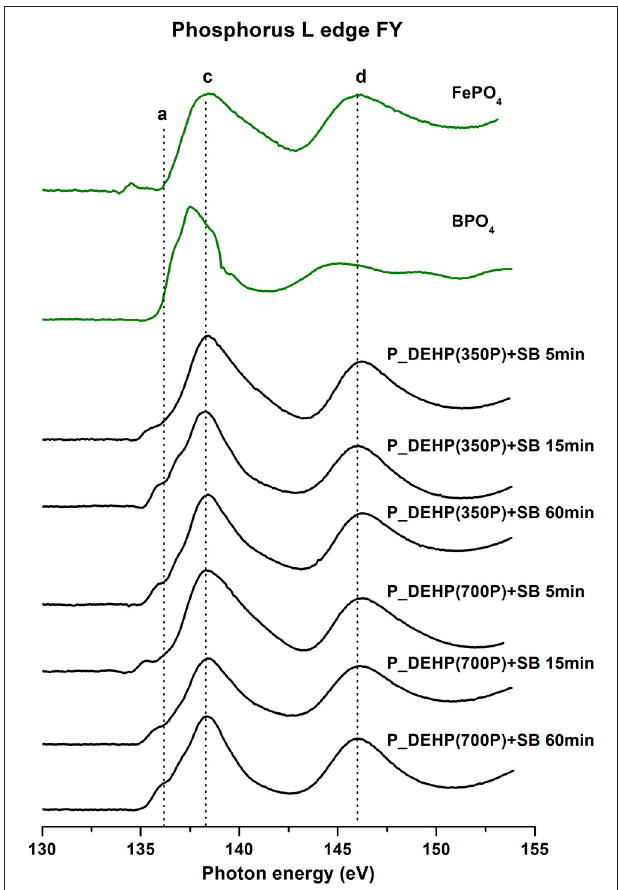
FIGURE 8 | Phosphorus L-edge FY spectra of tribofilms (black lines) derived at 5, 15, and 60min test for P_DEHP(350P) + SB and P_DEHP(700P) + SB lubrication along with model compounds (green